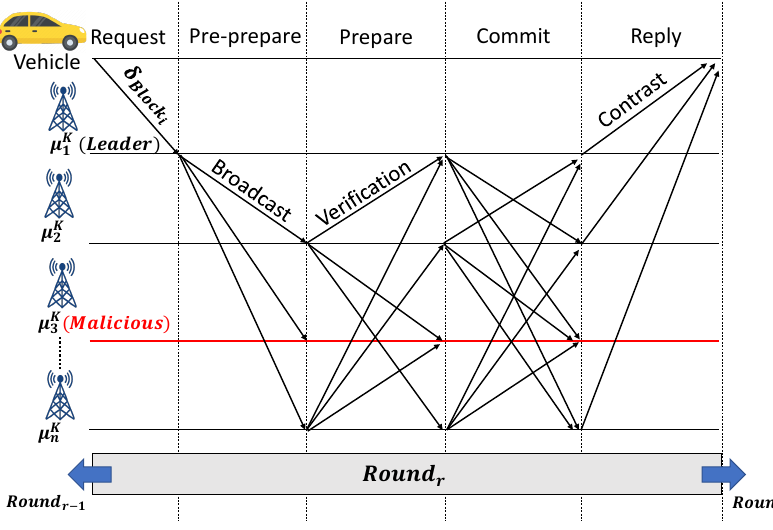
Figure 2. Consensus process in validation block smart contract